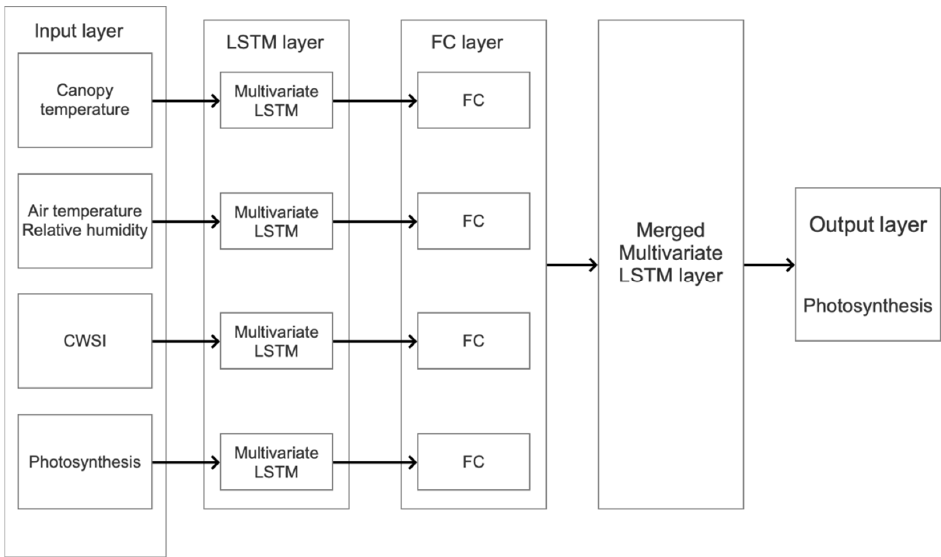
Figure 5. Structure of the designed MLSTM. Table 1. MSLTM model settings.